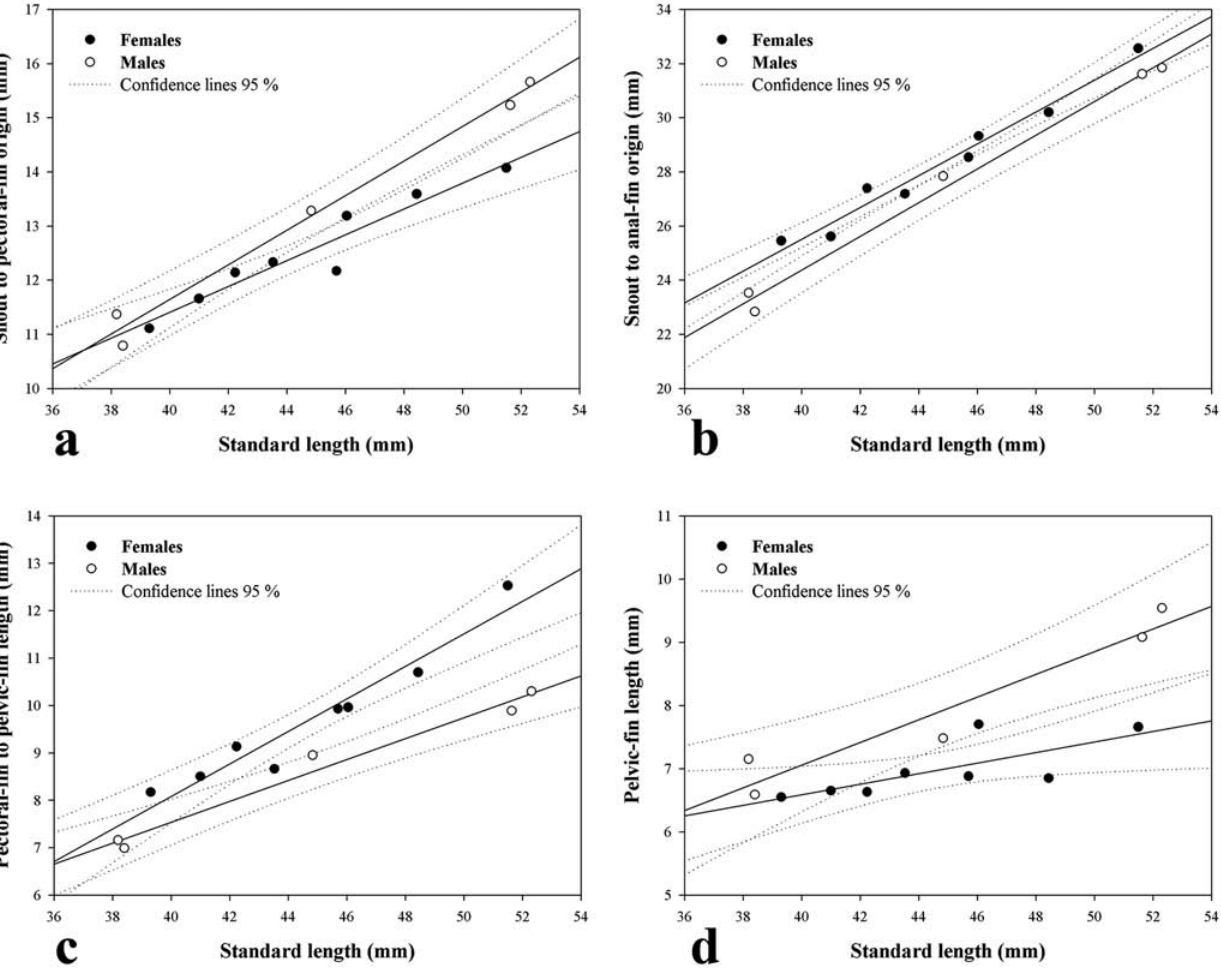
Fig. 4. Comparative regression plots of females (n = 8) and males (n = 5) of Chrysobrycon yoliae . All variables as function of SL: ( a ) Snout to pectoral-fin origin (females: r 2 = 0.92; males: r 2 = 0.99), ( b ) snout to anal-fin origin (females: r 2 = 0.97; males: r 2 = 0.99), ( c ) pectoral-fin to pelvic-fin length (females: r 2 = 0.93; males: r 2 = 0.98), ( d ) pelvic-fin length (females: r 2 = 0.55; males: r 2 =